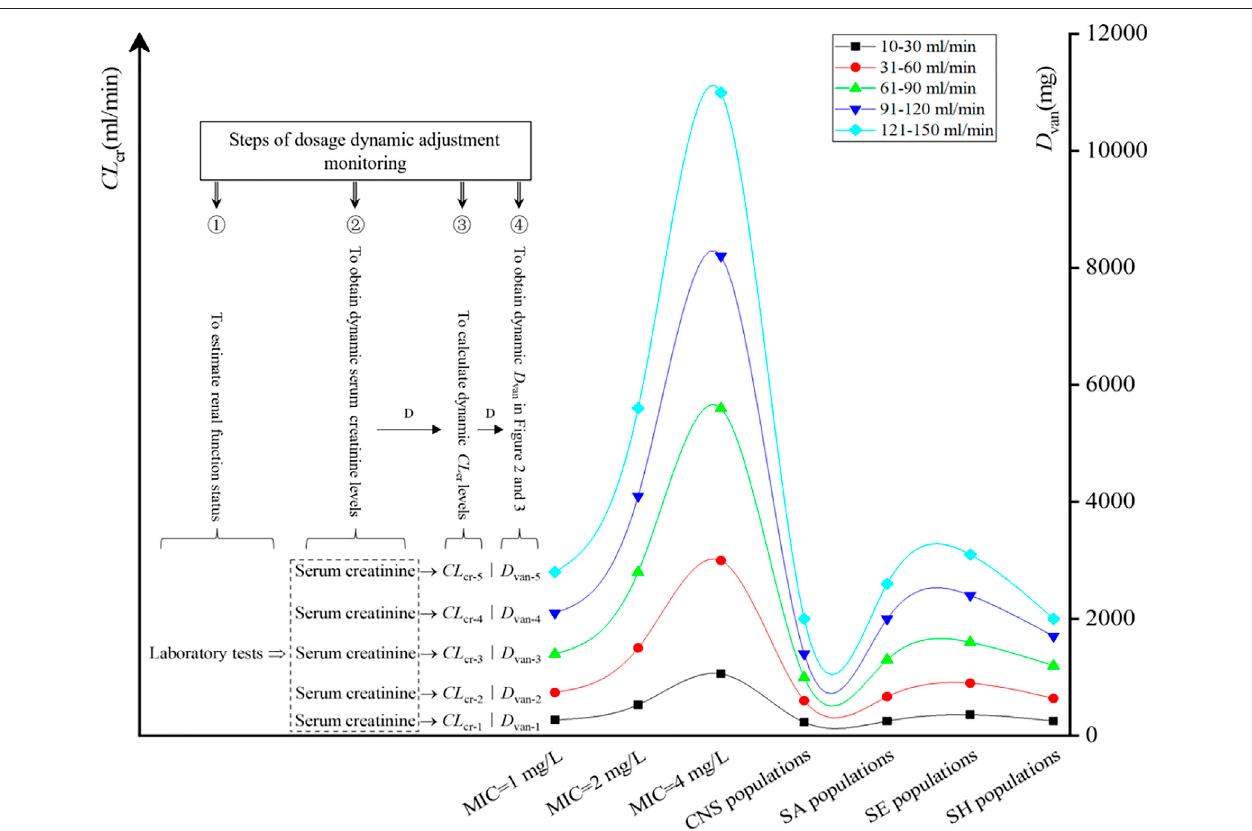
FIGURE 5 | Steps of dosage dynamic adjustment monitoring. D, dynamics; CNS, coagulase-negative Staphylococcus ; SA, Staphylococcus aureus ; SE, Staphylococcus epidermidis ; SH, Staphylococcus haemolyticus .